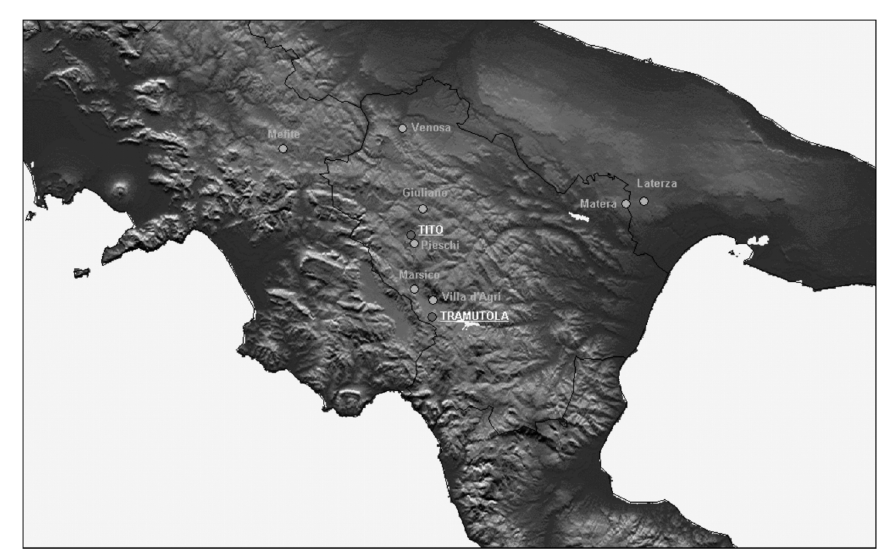
Fig. 1. Geophysical monitoring network in the Basilicata Region: the main test sites are Tramutola and Tito. Further stations are installed at Pieschi, Marsico, Villa d’Agri, Matera, Laterza, Giuliano, Venosa and Mefite.